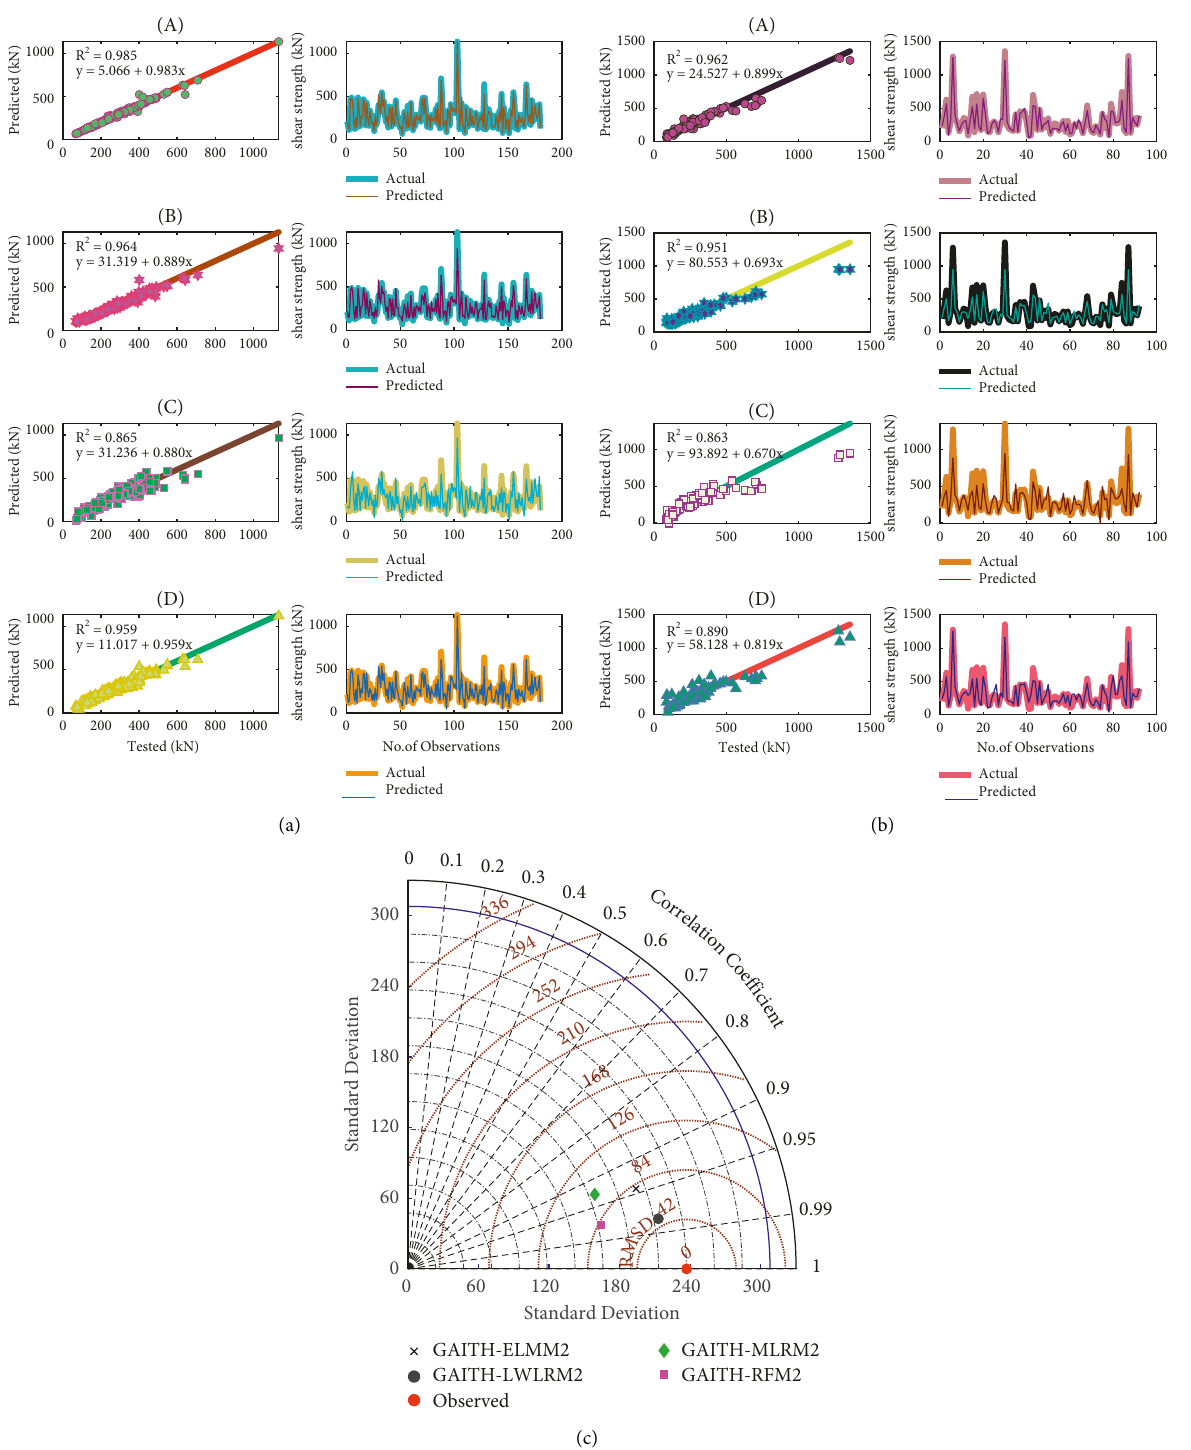
, GAITH − RF , GAITH − M 2 M 2